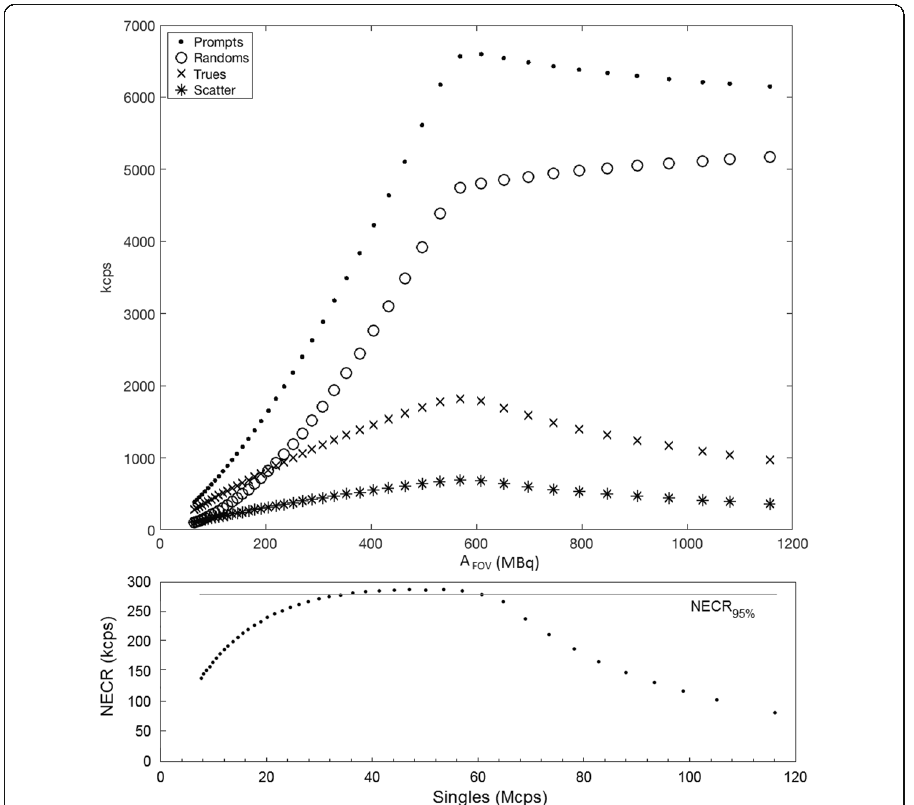
Fig. 1 Top — Count-rate performance of the PET-MR system with activity present in the myocardial chamber of an anthropomorphic torso phantom. Of note is a discontinuity in the response at a maximum prompt rate of 6596 kcps (corresponding to a singles rate of 64.9 Mcps), above which events become affected by counting losses. Bottom — Noise equivalent count rate (NECR), with a peak rate of 286 kcps at a singles rate of 47.1 Mcps, and NECR 95% of 34.1